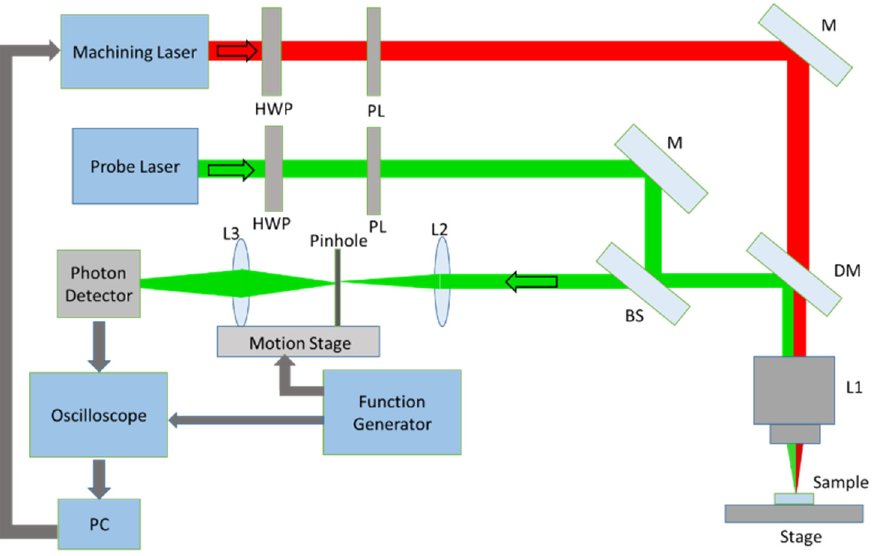
Figure 1. Schematic optical layout for real-time depth monitoring. HWP: Half-Wave Plate; PL: Polarizer; DM: Dichroic Mirror; BS: Beam Splitter; M: Mirror; and PC: Personal Computer.